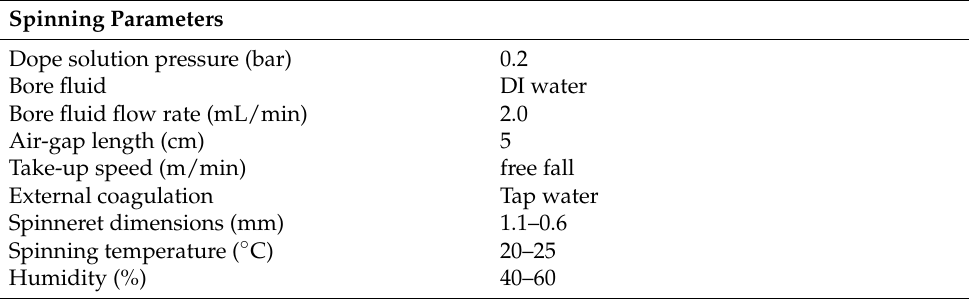
Table 2. Spinning parameters for FCNT/PES nanocomposite HF membranes. Spinning